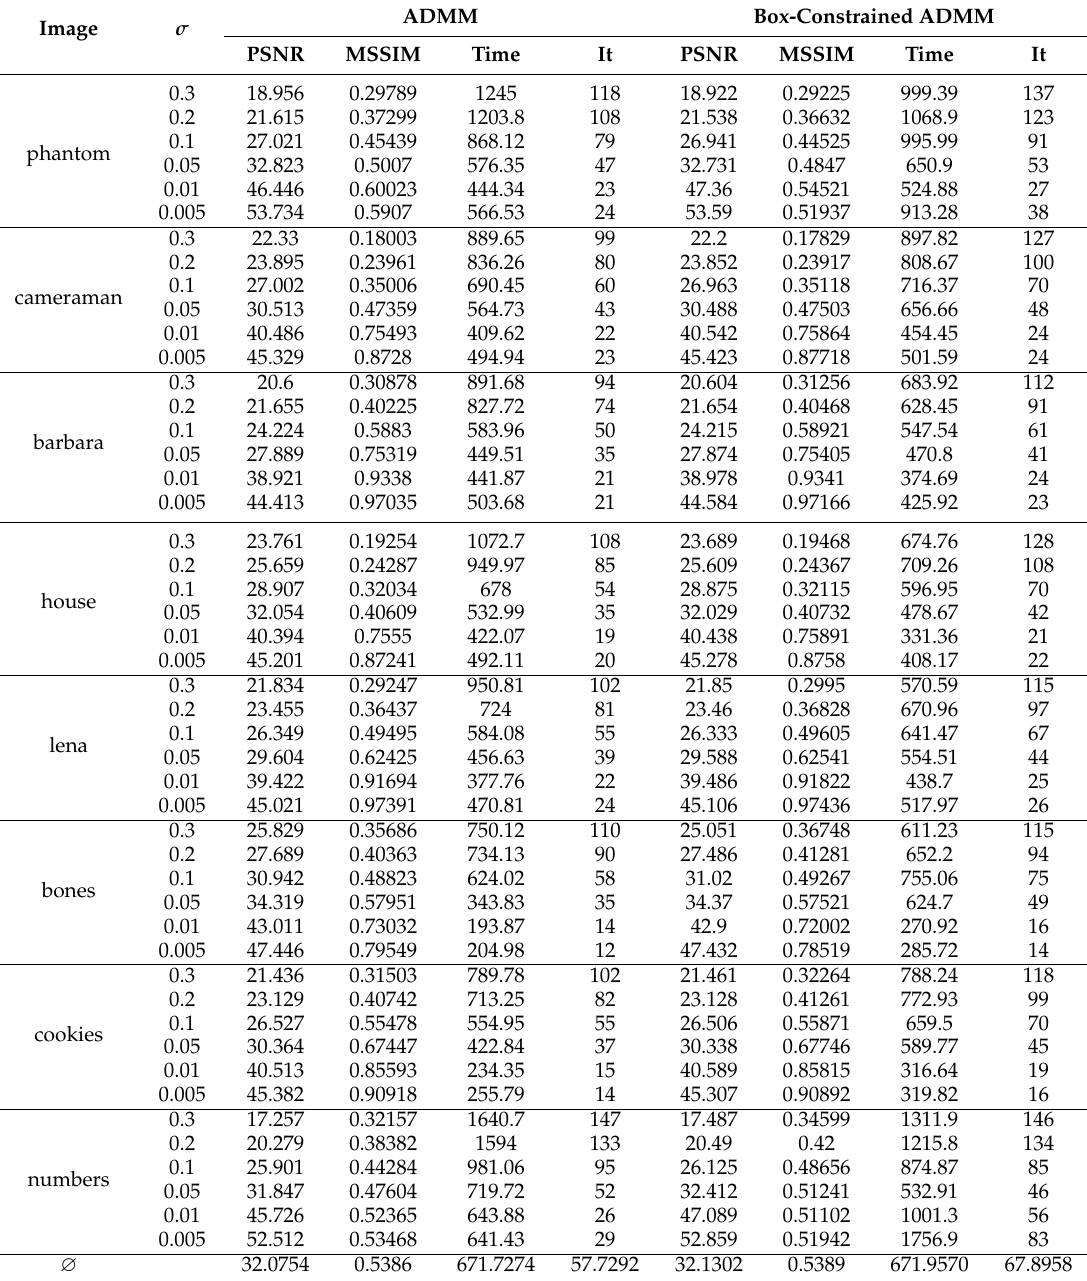
Table 8. PSNR- and MSSIM-values of the reconstruction of different images corrupted by Gaussian white noise via the ADMM by solving the constrained